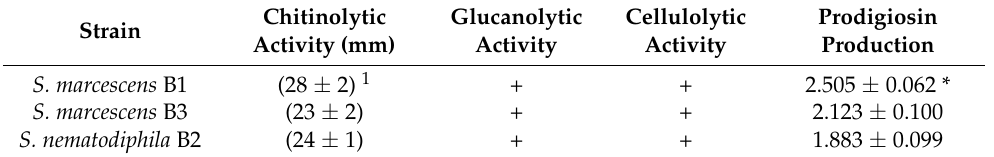
Table 2. Production of compounds with antifungal activity by S. marcescens and S. nematodiphila strains.